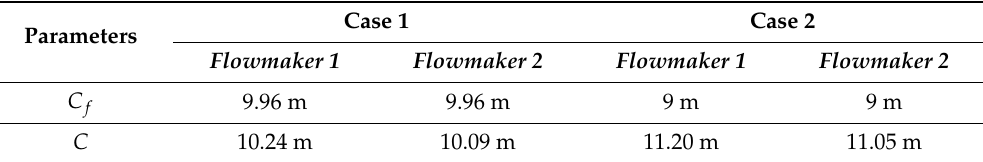
Table 3. Positioning of flowmakers in Case 1 and Case 2.